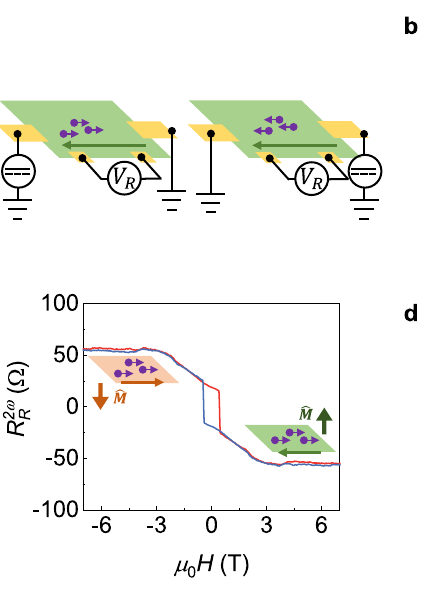
measured at the right edge and left edge, respectively. The injected current I RMS is 5 μ A.The measurements are performed at11Kwith topgate voltage of − 2V.Insets showschematicillustrationsoftheinterplaybetweenchiraledgestatesand2Dbulk transport channels (e.g., surface states) at different magnetic states.